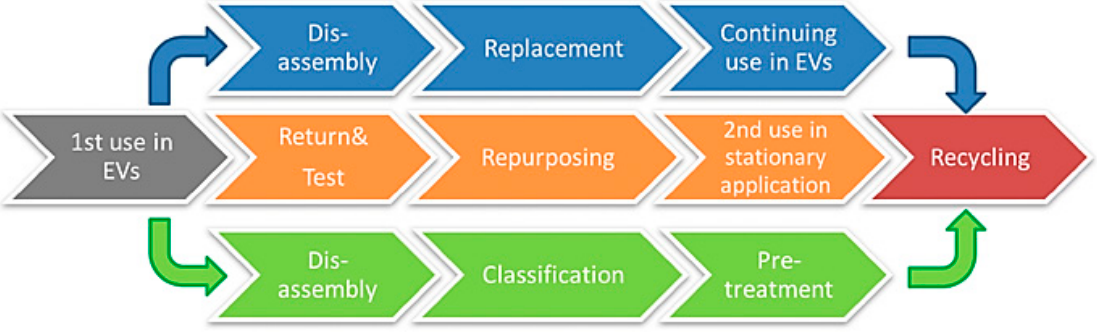
Figure 23. Pre-treatments for lithium-ion recycling process [252,253].